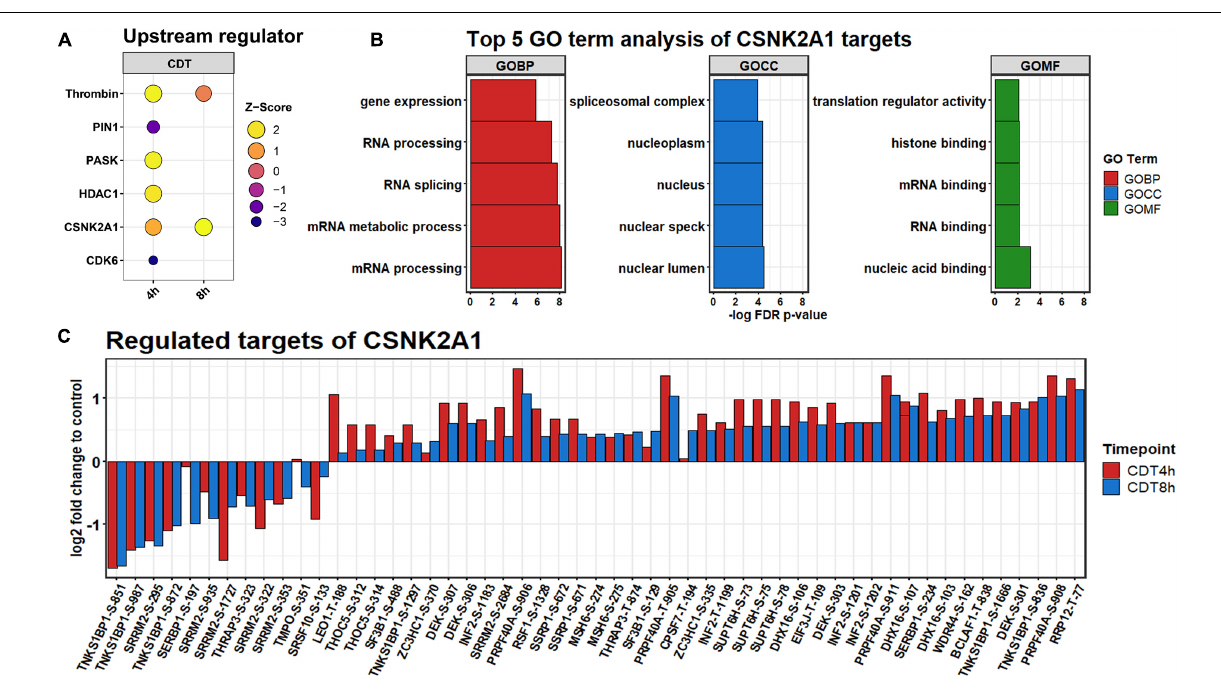
The mono-ADP-ribosylation could be detected at Arg-177 proved by an MS2 spectrum with an Andromeda score of